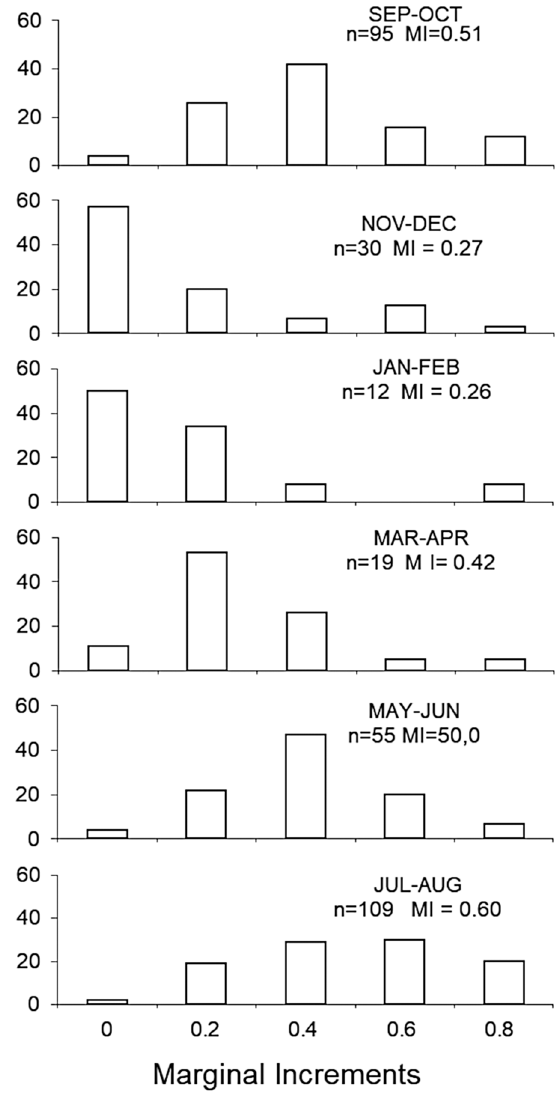
Fig. 6. Bimonthly frequency distributions of marginal increments (MI) with two and three rings in the scales of Pagrus pagrus from southern